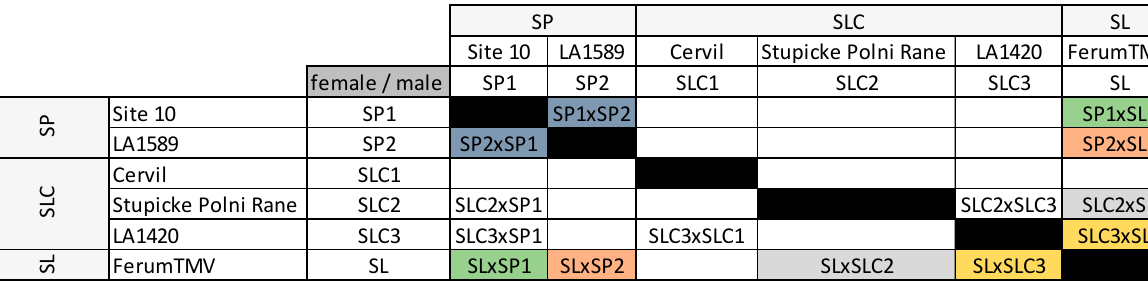
Figure 1. The six parental lines and 14 F1 hybrids (HF1) studied in the factorial design. Names are abbreviated to indicate the species the parental lines belong to. HF1 are named after the “female” x “male” they originate from. ‘*’ indicates that the HF1 was also studied in [25]. Pairs of reciprocal HF1 are represented in the same color. ‘SP’: S. lycopersicum pimpinellifolium; ‘SLC’: S. lycopersicum var. cerasiforme ; ‘SL’: S. lycopersicum var. lycopersicum.